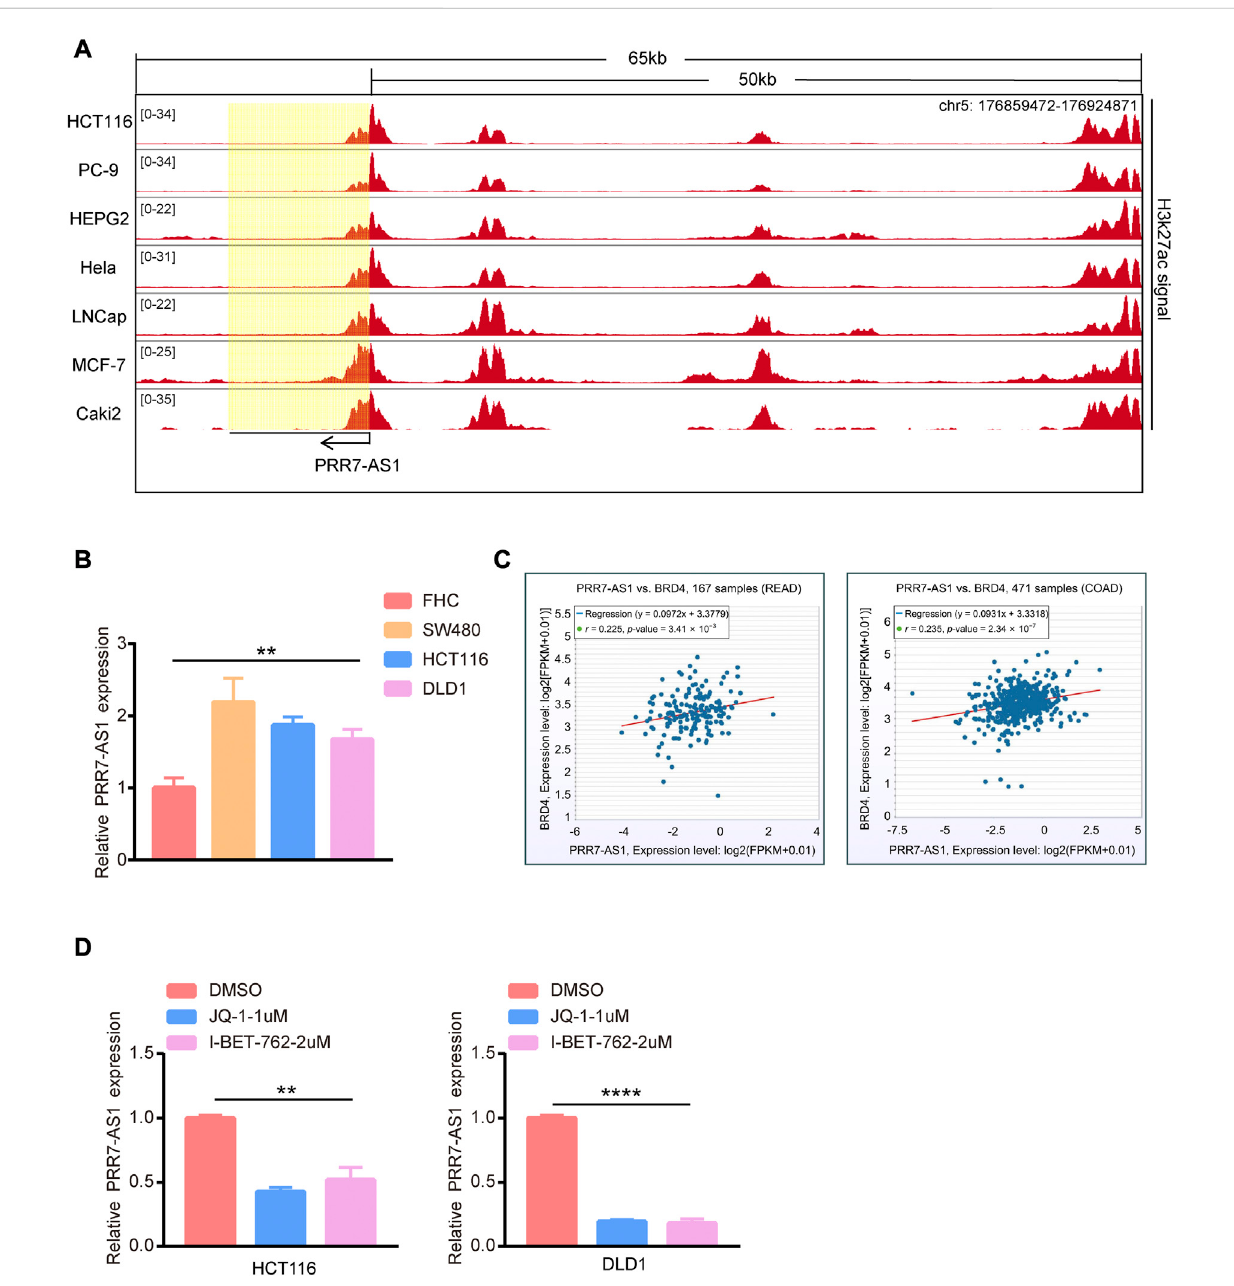
TheeffectofsuperenhanceractivityonPRR7-AS1expression. (A) H3K27acsignalsinPRR7-AS1genelociinmultiplecancercells.TheCHIP-seqdata wasdownloadedfromtheENCODE database. (B) The RNAexpression levels ofPRR7-AS1weremeasured byqPCRincolorectalcancercell lines. (C) The correlation between PRR7-AS1 and BRD4 expression in colorectal cancer was analyzed by using the ENCORI database. (D) The relative expression of PRR7-AS1 after JQ-1 and I-BET-762 treatment was detected by qPCR. ** p < 0.01, **** p <